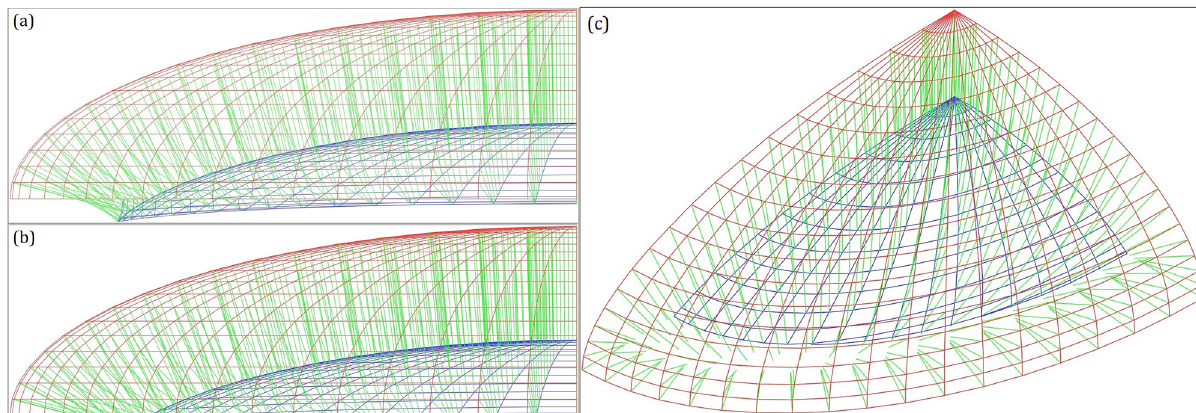
Figure 4: A fragment of the ellipsoid S u v , ( ) and the o ff set surface S u v off , d 2